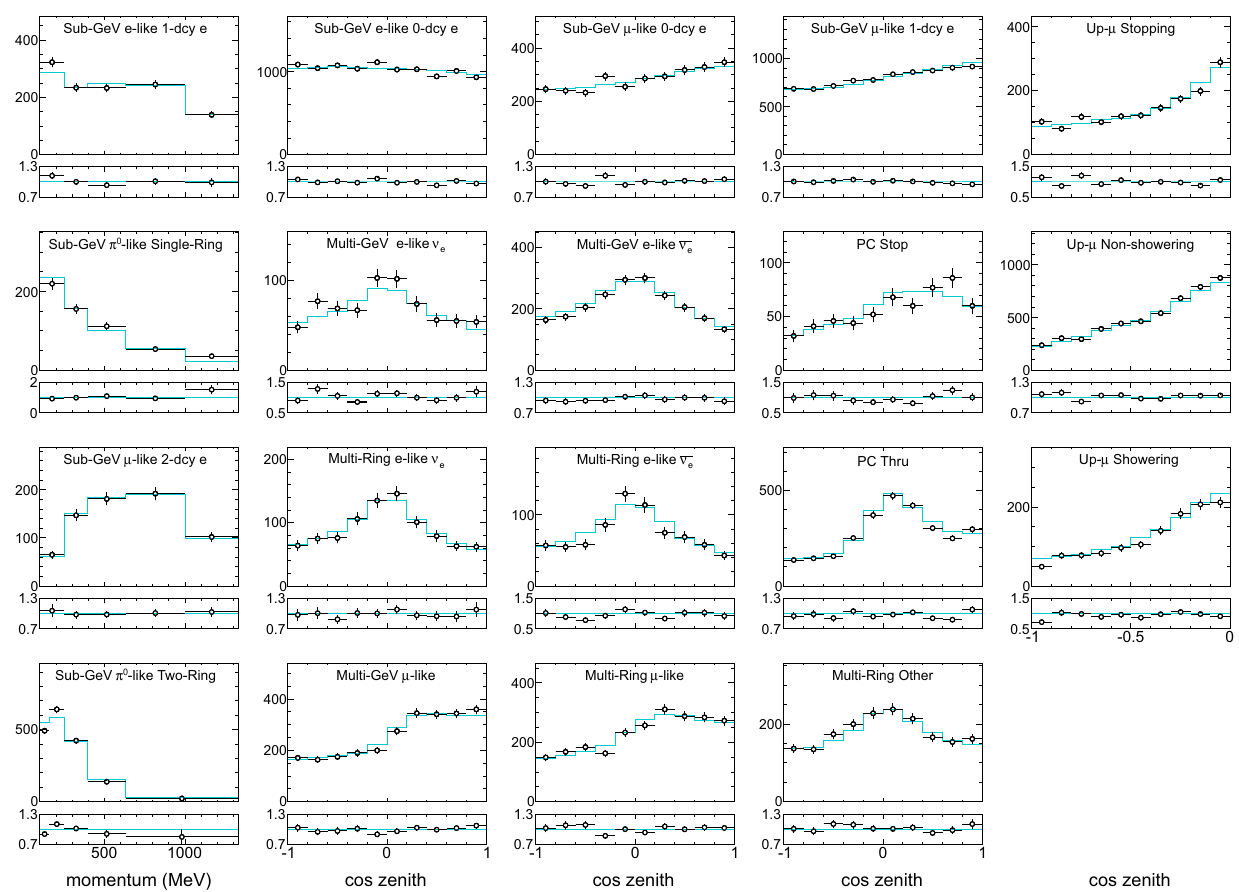
Fig. 5 Latest results of the atmospheric neutrino measurement [41]. Total 328 kton · years of data spanning over SK-I to SK-IV are used for the fit. The histograms show the best fit of the MC. The sub-panels beneath each figure denotes the ratio with respect to the best